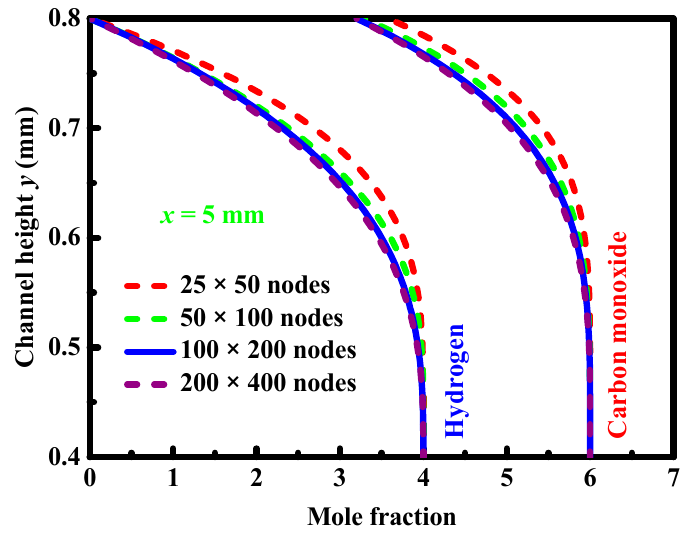
Figure 3. Example of the transverse profiles of carbon monoxide and hydrogen mole fractions for meshes with different nodal densities. The parameters used are ϕ = 0.167, β H = 30.0%, β O = 60.0% , T in = 300 K, u in = 2.0 m/s, and p in = 0.6 MPa.